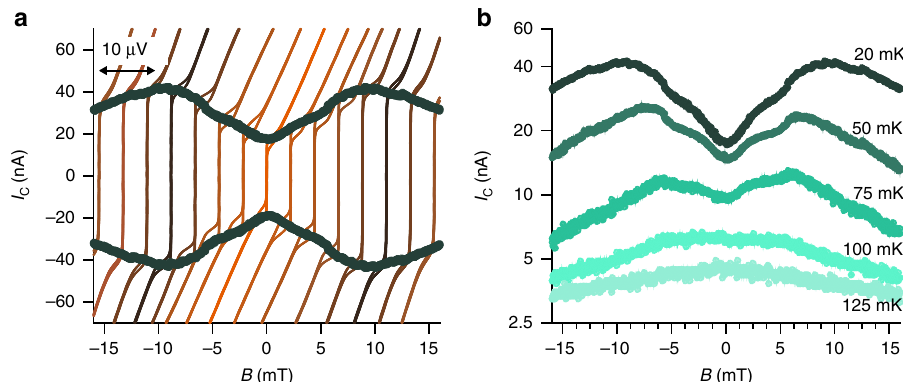
Fig. 4 Current voltage characteristics as a function of magnetic fi eld and temperature for a typical junction after thermal cycling. a IVCs of a second device ( w = 500 nm and L = 100 nm) are shown as a function of B after thermal cycling. The curves are shifted in voltage by a value proportional to the magnetic fi eld. The green points represent the magnetic pattern of the junctions obtained using a voltage criterium V = 600nV. Also in this case the magnetic pattern presents a very pronounced dip at B = 0. b Evolution of the magnetic pattern shown in a as a function of the temperature. The dip fl attens out at a temperature close to